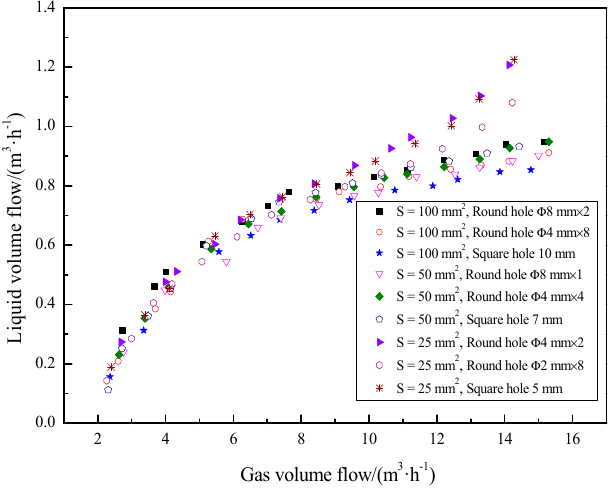
Figure 4. Changes of liquid flow gas flow under different intake modes at submergence Ratio of 0.5.